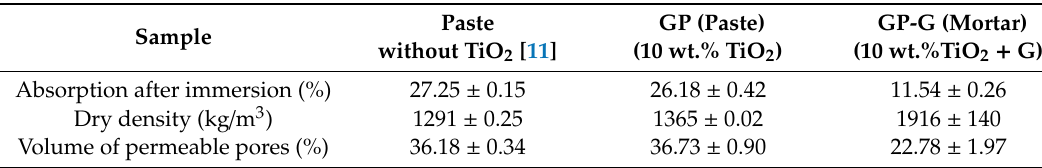
Table 3. Physical properties of the GP and GP-G samples.